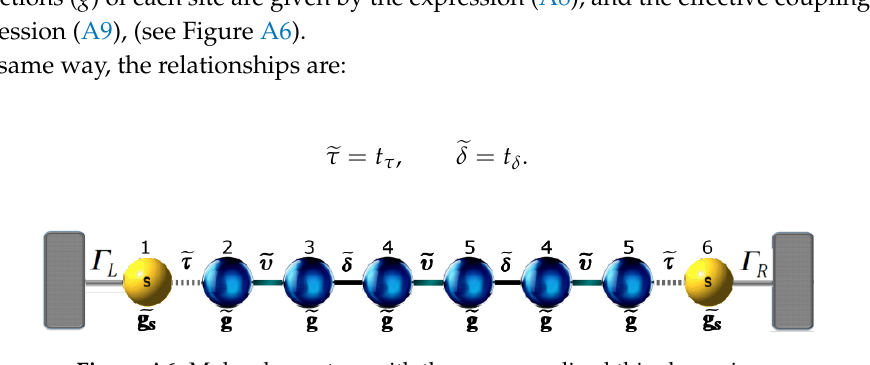
Figure A6. Molecular system with three renormalized thiophene